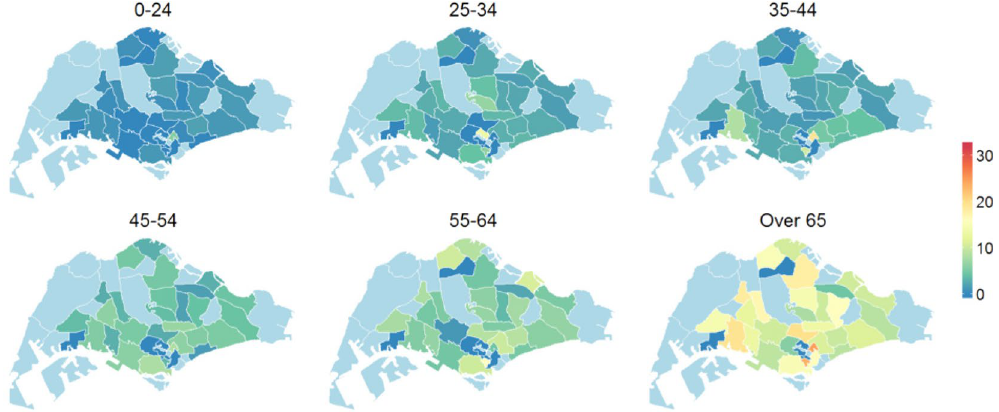
Figure 6. Age and zonal distribution of TB among resident Singaporeans in the year 2010. The values are adjusted for the population size and expressed per 10,000 of the susceptible population. Plots were created in statistical program R 22 using the package spatstat 19 . Administrative and national political coordinates of Singapore were provided, for academic research and publication, by the Singapore Land Authority (SLA) 24